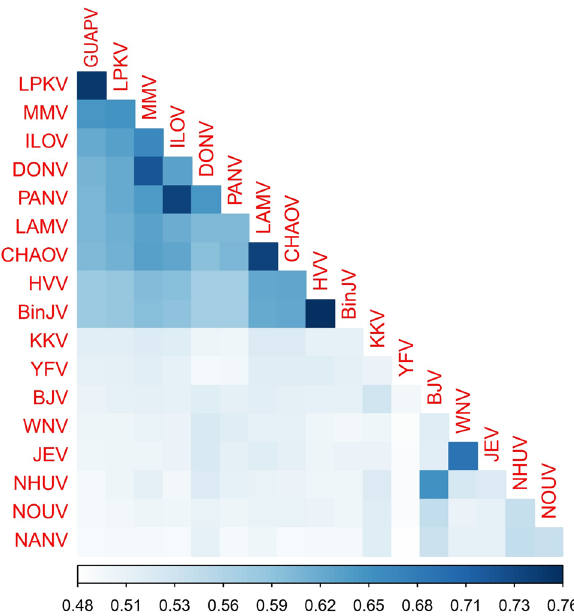
Figure 3. Nucleotide pairwise identity of distinct flaviviruses. Values are indicated by color shading. Pairwise identity matrix was generated from complete genomes nucleotide sequences using p-distance model and 1000 bootstrap replication in MEGAX software version 10.0.5. GUAPV (Guapiaçu virus), LPKV (Long Pine Key virus), MMV (Marisma mosquito virus), ILOV (Ilomantsi virus), DONV (Donggang virus), PANV (Panmunjeom flavivirus), LAMV, CHAOV (Chaoyang virus), HVV (Hidden valley virus), BinJV (Binjari virus), KKV (Kampung Karu virus), YFV (Yellow fever virus), BJV (Barkedji virus), WNV (West nile virus), JEV (Japanese encephalitis virus), NHUV (Nhumirim virus), NOUV (Nienokoue virus) and NANV (Nanay